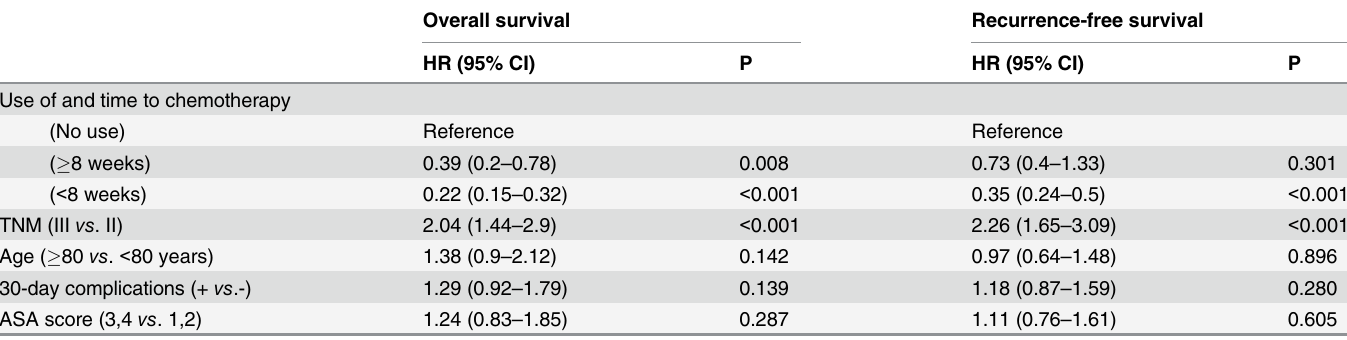
Table 4. Prognostic factors for survival on Cox proportional hazard modeling. Overall